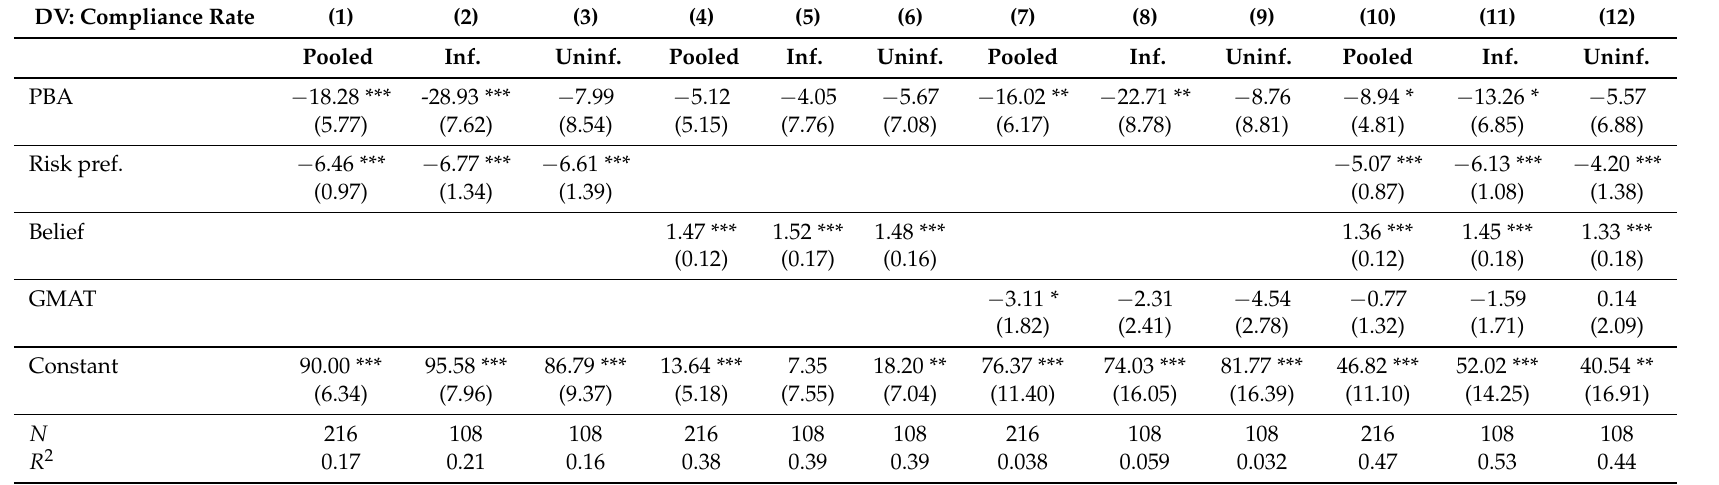
Table A13. Allocation treatment regressions (OLS) with